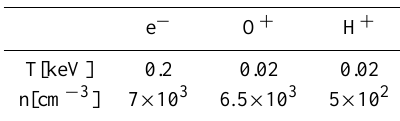
Table 2. Reference density and temperature of the ionospheric species considered in the current-voltage relationship (Eqs. 5,